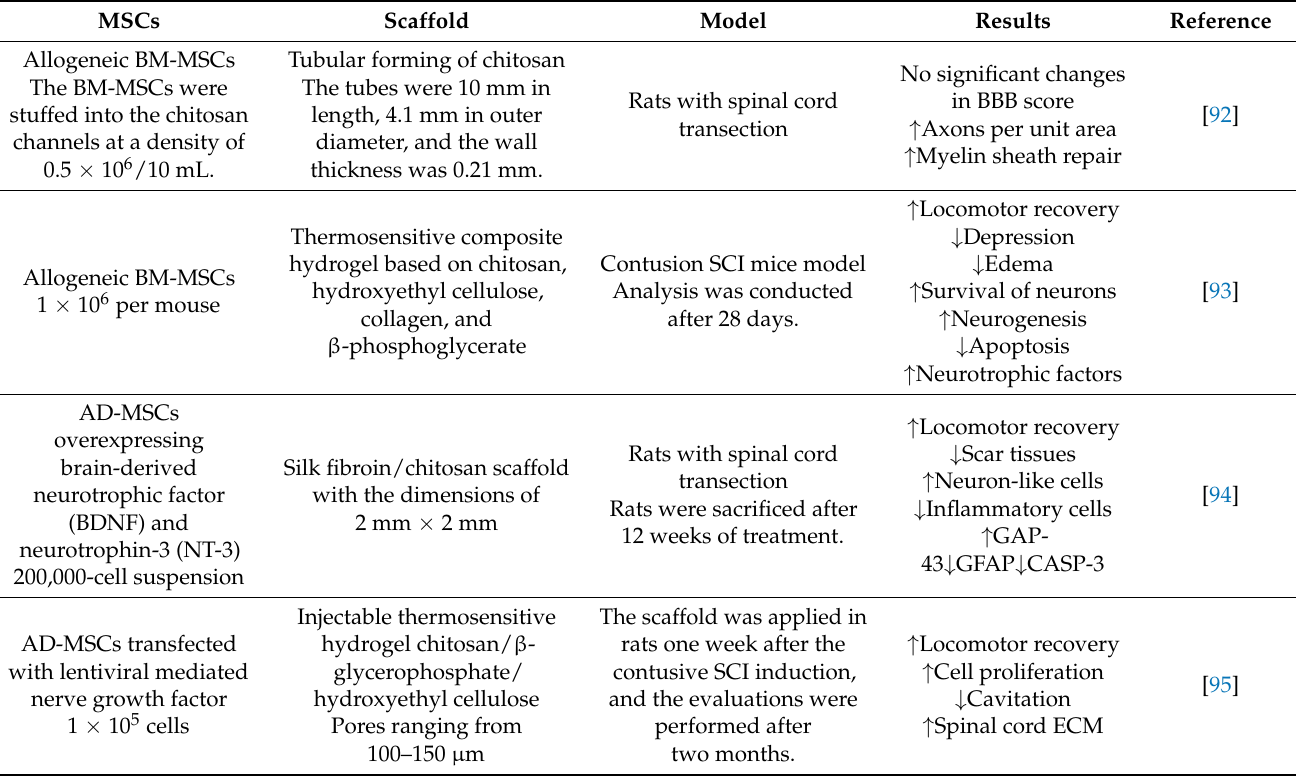
Table 3. Overview of the studies evaluating biochemical and cellular changes using MSC-enriched chitosan scaffolds in in vivo SCI